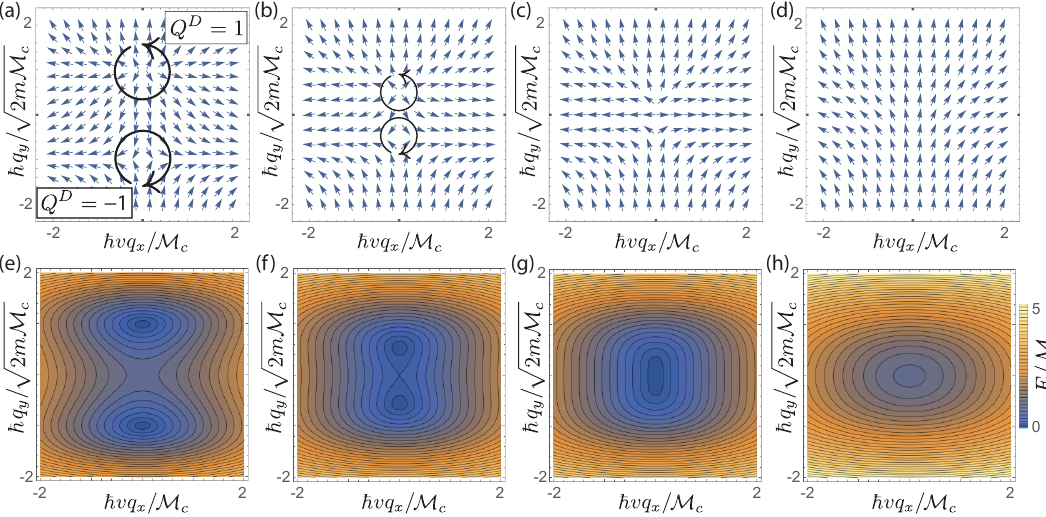
Figure 2: Illustration of the appearance of a semi-Dirac point as a critical point of a topological phase transition described by Hamiltonian (3). Figures (a)-(d) show the direction of the pseu- (cid:126) (cid:126) h ( q ) / | h ( q ) | [ Eq. (3) ] and figures (e)-(h) the energy spectrum E ( q ) [ Eq. (4) ] as domagnetic field a function of momentum q for different values of (cid:77) : (a),(e) (cid:77) = 2 (cid:77) , (b),(f) (cid:77) = 1.3 (cid:77) , c c (c),(g) (cid:77) = (cid:77) and (d),(h) (cid:77) = 0. For (cid:77) > (cid:77) this Hamiltonian describes two Dirac c c = 0 and q = ± (cid:112) 2 m ( (cid:77) − (cid:77) ) / ħ h [ (e), (f) ] . The pseudomagnetic field points located at q x y c (cid:126) h ( q ) forms vortices around these points with opposite chiralities (i.e. a vortex-antivortex pair) [ (a), (b) ] . Therefore, it is possible to define topological charges Q D = ± 1 for the Dirac points (cid:126) h ( q ) around them [ (a), (b) ] . When (cid:77) approaches based on the direction of the winding of (cid:77) from above the two Dirac points with opposite topological charges approach each other c in the momentum space and they meet at (cid:77) = (cid:77) forming a semi-Dirac point described by c Hamiltonian (2) [ (c), (g) ] . For (cid:77) < (cid:77) the vortex-antivortex pair is annihilated and the c ħ h 2 = (cid:67) (cid:68) 2 > 0, spectrum E ( q ) of the system is fully gapped [ (d), (h) ] . We have chosen 1 2 m (cid:77) > 0 and (cid:67) = c